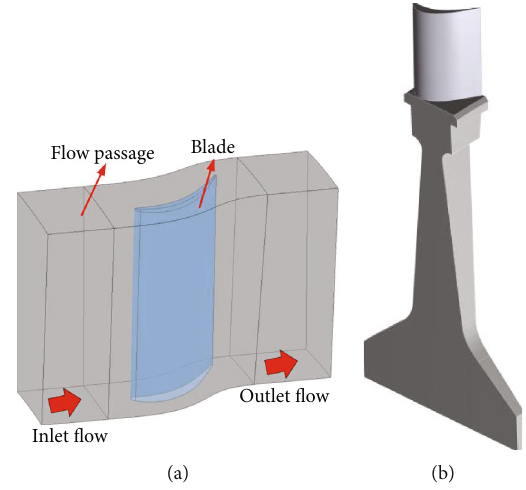
Figure 5: The geometric models. (a) The fl uid fl ow model. (b) The turbine blisk model.